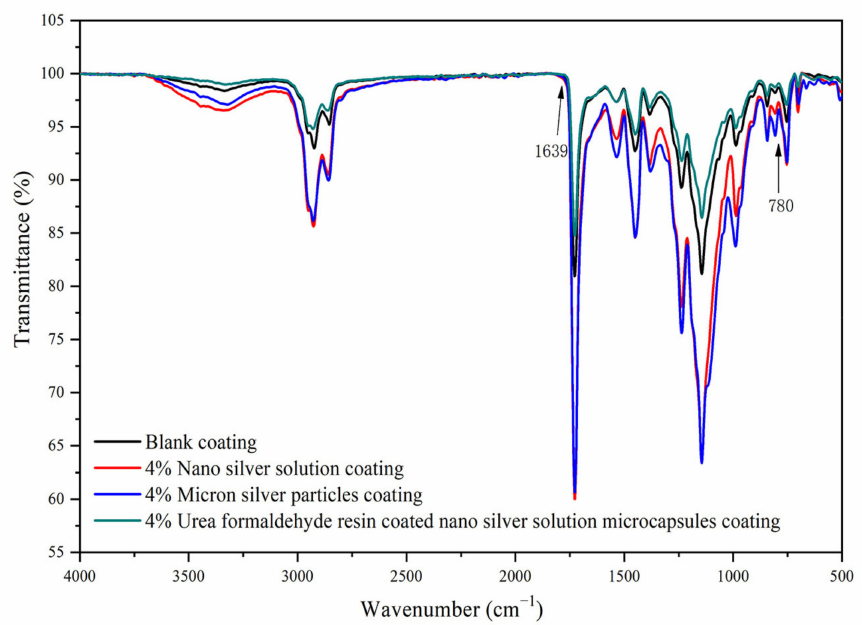
Figure 7. Infrared spectrum of paint film with 4.0% micron silver particles, 4.0% nano-silver solution, and 4.0% urea formaldehyde resin coated nano-silver solution